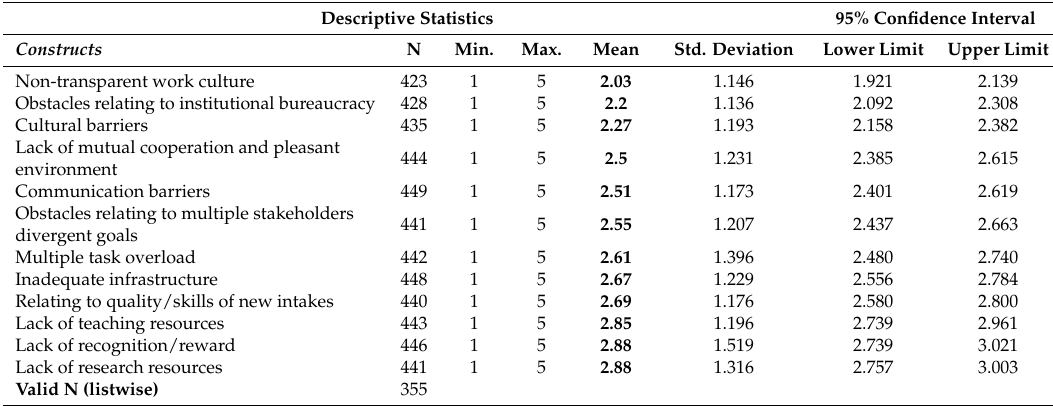
Table 2. Descriptive results—Obstacles to teaching and learning goals.